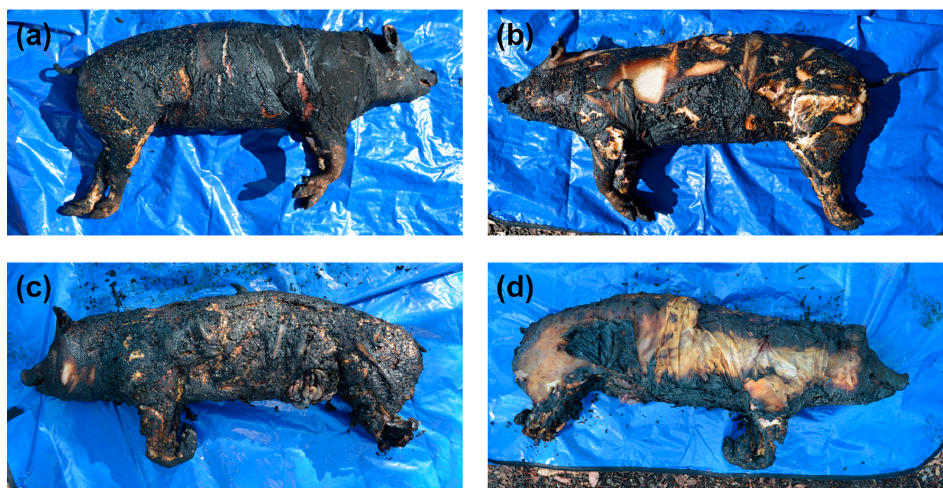
Figure 2. Photographs of the ( a ) topside and ( b ) underside of the pig carcass burnt without gasoline and the ( c ) topside and ( d ) underside of the pig carcass burnt with gasoline.